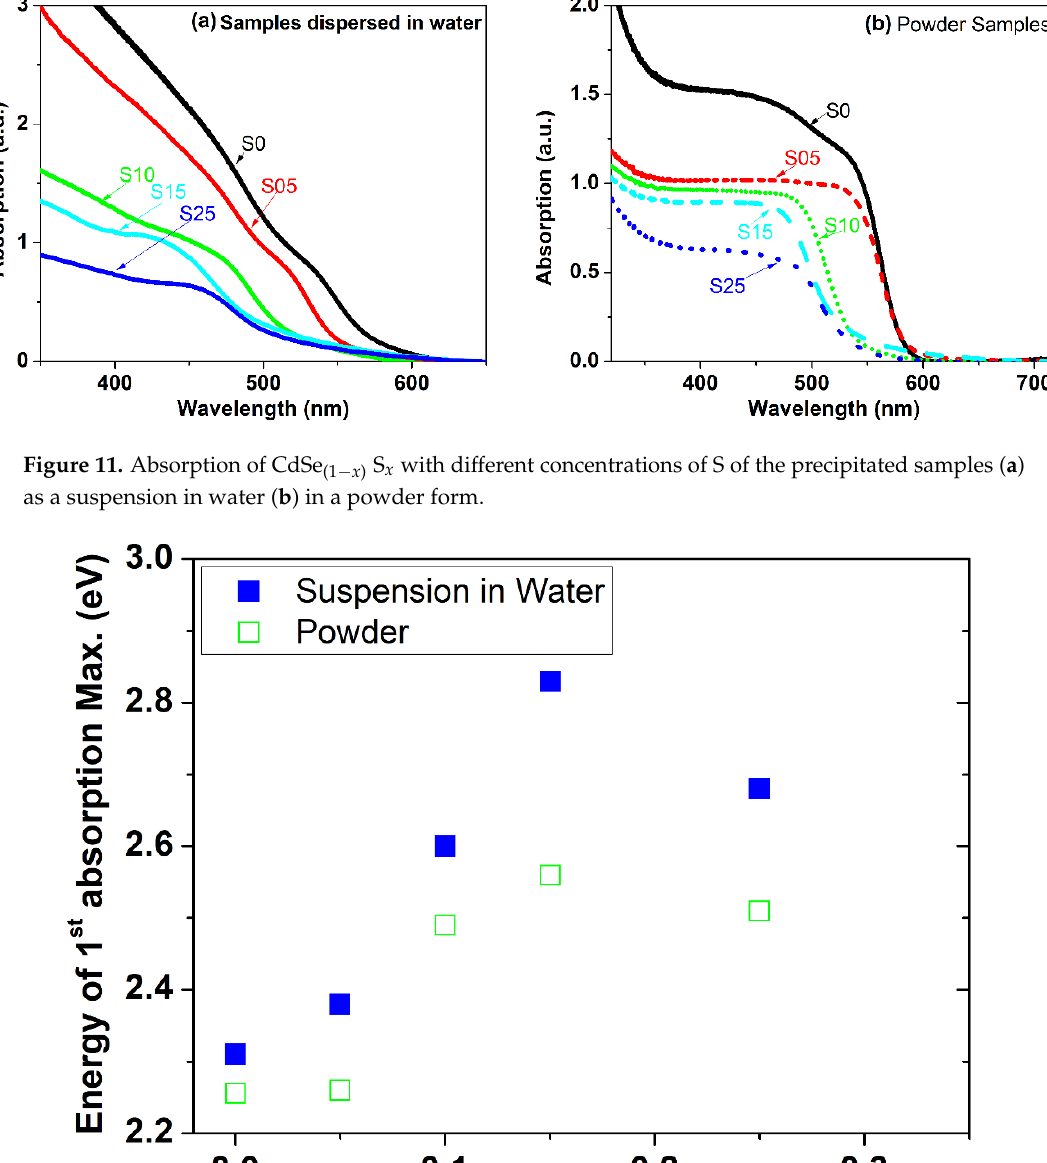
Figure 10. Effect of time on the position of the absorption maximum for the CdSe bare and alloyed structure with different S contents.